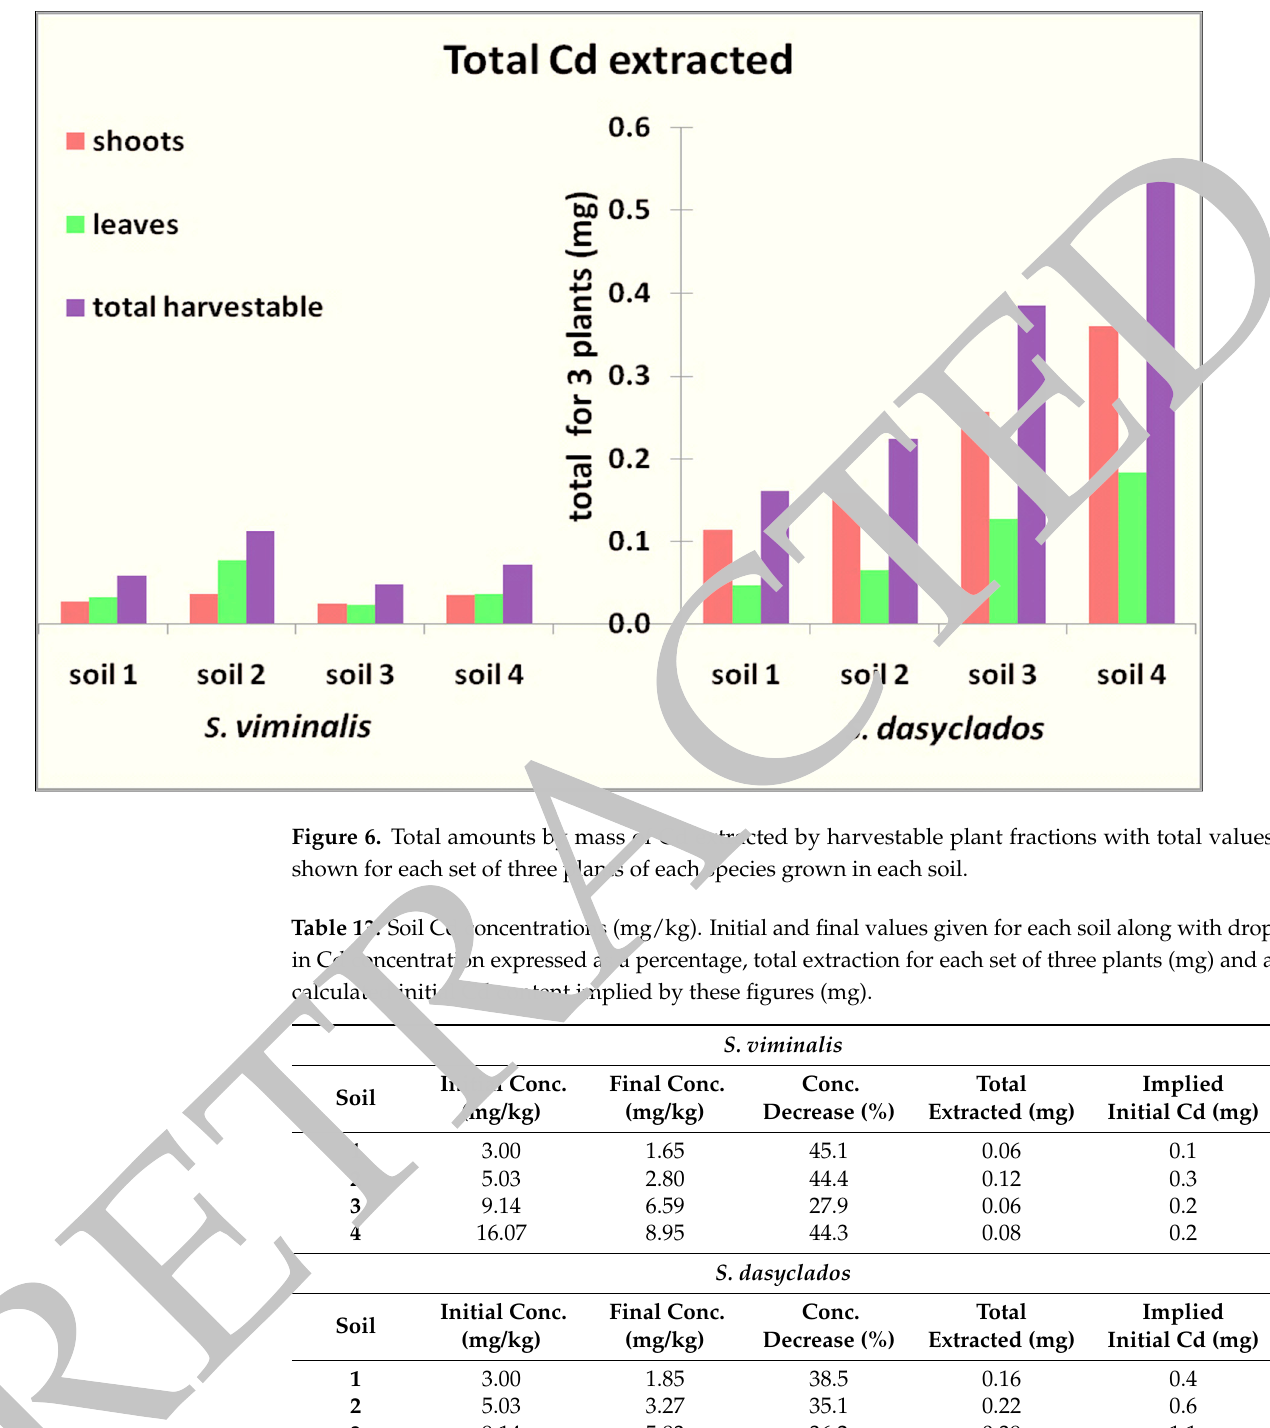
Table 13. Soil Cd concentrations (mg/kg). Initial and final values given for each soil along with drop in Cd concentration expressed as a percentage, total extraction for each set of three plants (mg) and a calculated initial Cd content implied by these figures (mg).